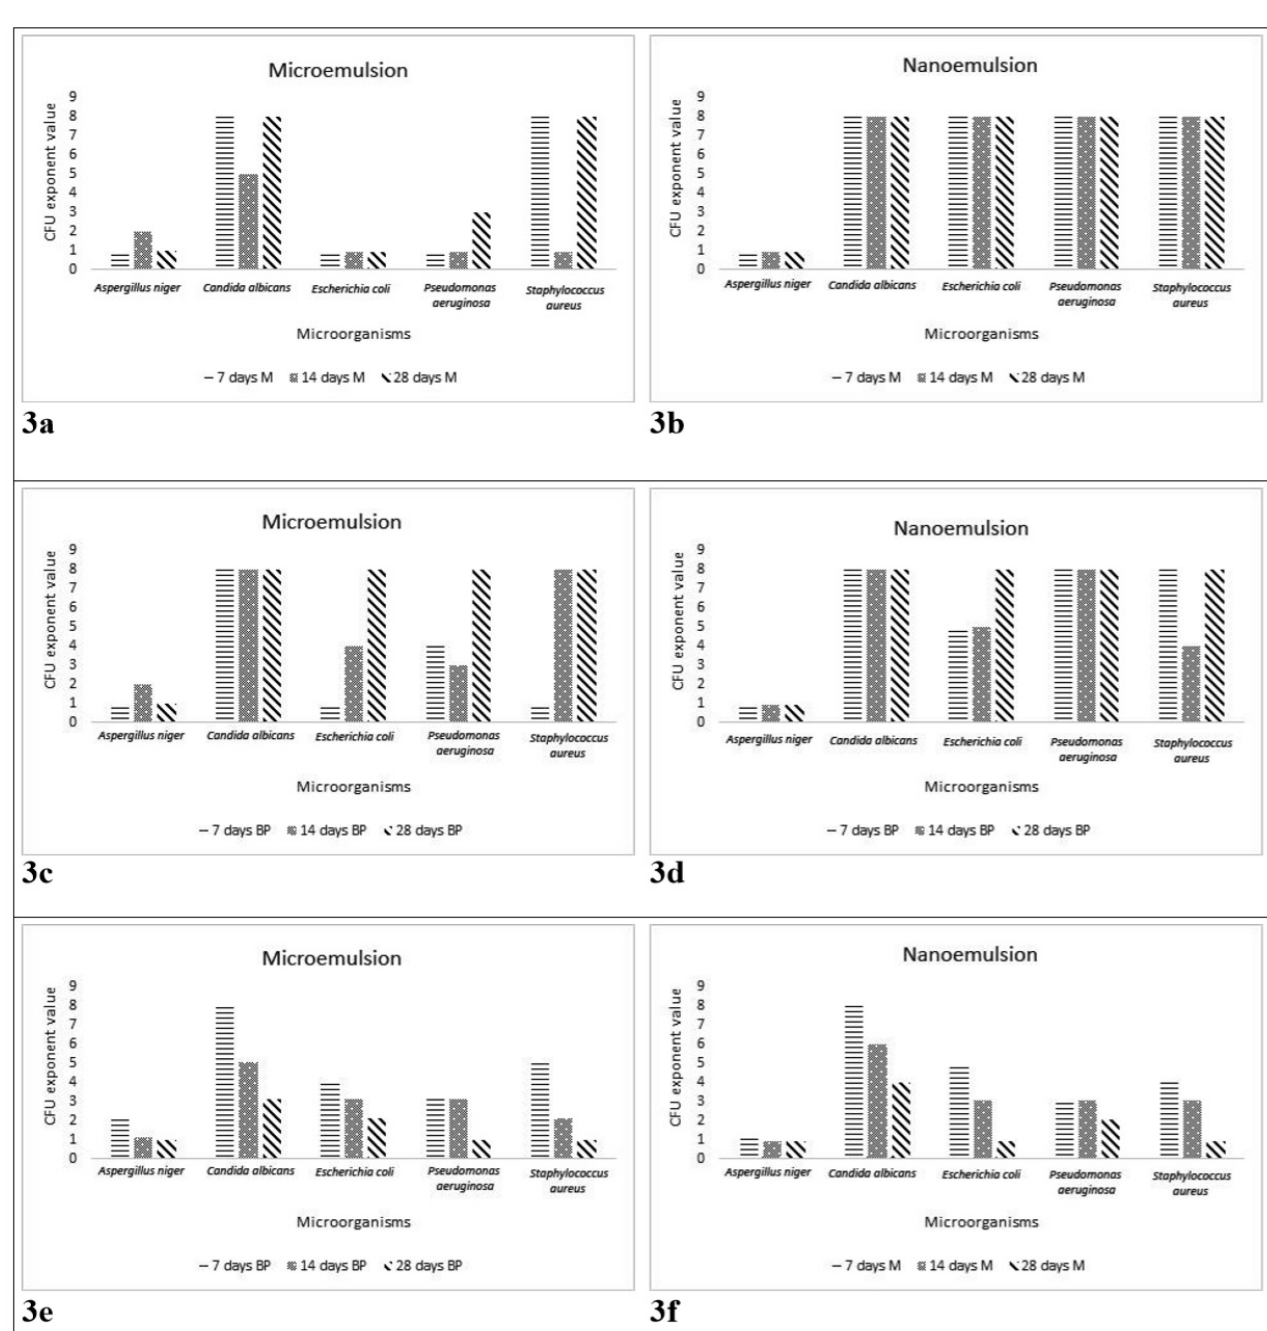
FIGURE 3 - Preservative efficacy analysis of different preservatives in micro- and nanoemulsions for five microorganisms. 3a,b: methylparaben (M) at 0.2%; 3c,d: phenoxyethanol (and) benzoic acid (BP) at 0.5%; 3e,f: phenoxyethanol (and) methylparaben (and) ethylparaben (and) propylparaben (and) butylparaben (and) isobutylparaben (P) at